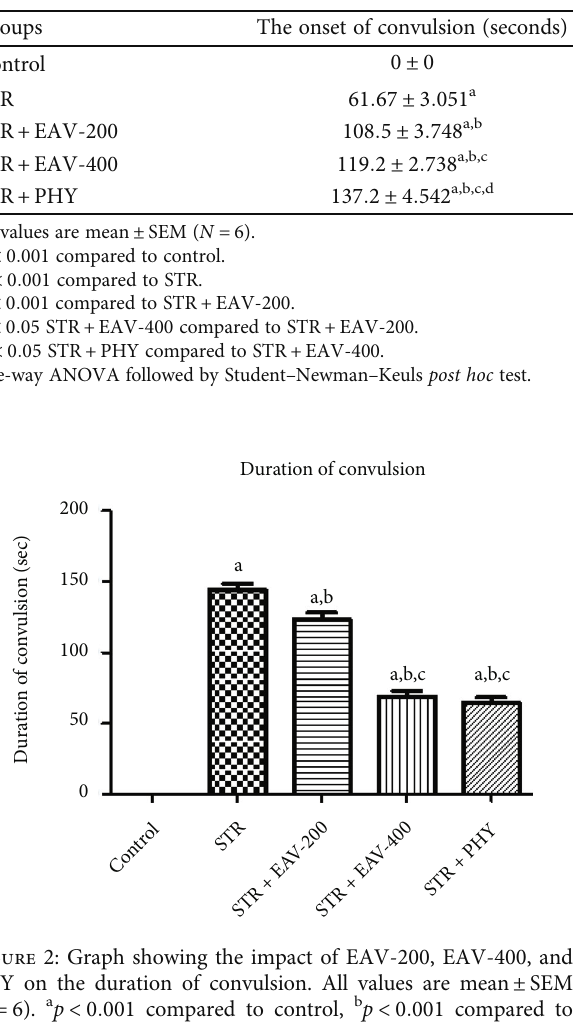
Table 4: Impact of EAV-200, EAV-400, and PHY on convulsion onset.